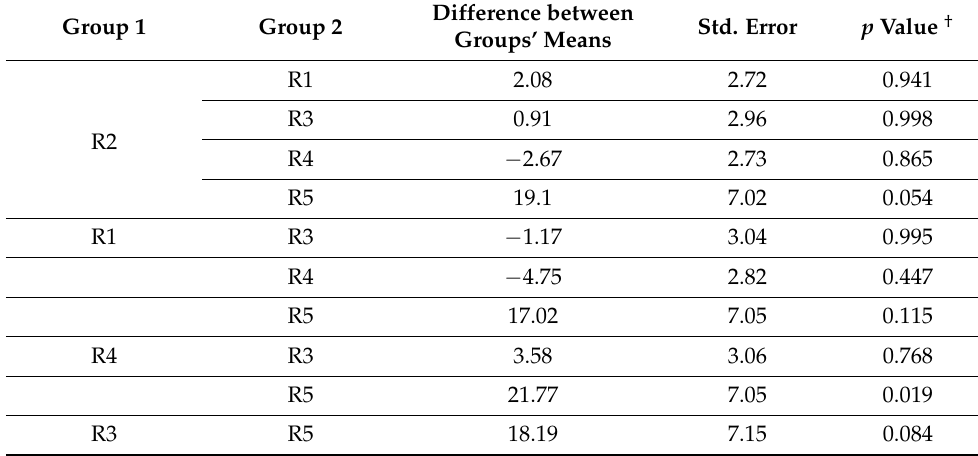
Table A3. Post hoc analysis of differences in JSE means between different residency